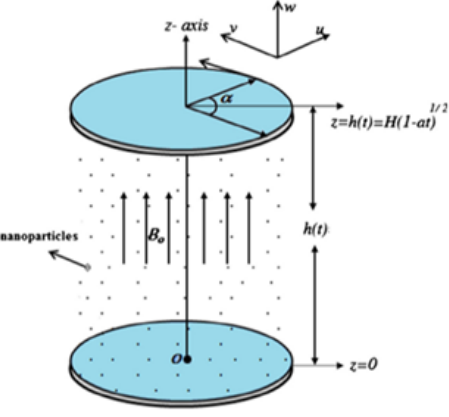
Figure 1. The squeezing flow of third grade fluid between parallel circular